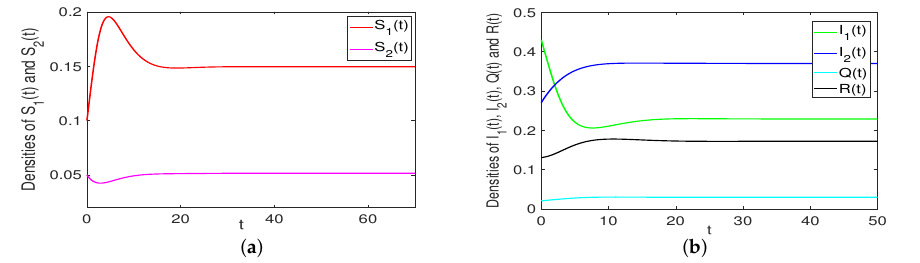
Figure 7. The dynamics of system (1) with (cid:60) 01 = 2.14 > 1 and (cid:60) 02 = 0.97 < 1. ( a ) The trajectories of S 1 ( t ) and S 2 ( t ) . ( b ) The trajectories of I 1 ( t ) , I 2 ( t ) , Q ( t ) and R ( t ) .